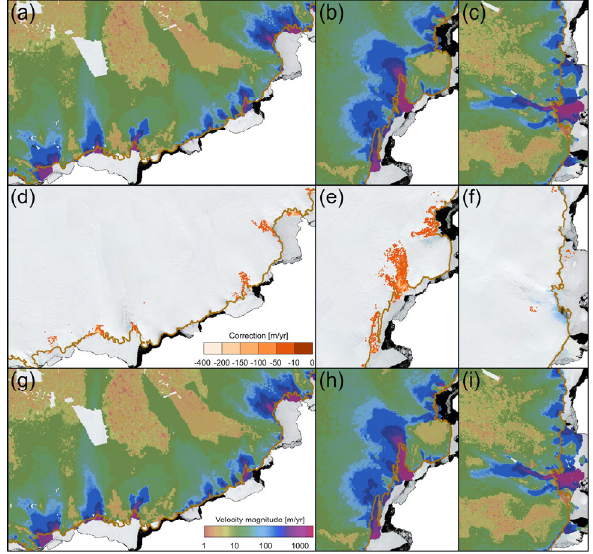
Figure 2. (a), (b), and (c) are the corresponding historical ice flow velocity maps of Boxes 1-3 in Figure 1 before correction. (d), (e), and (f) are the distributions of the corrected values in Boxes 1-3. (g), (h), and (i) are the corresponding historical ice flow velocity maps after